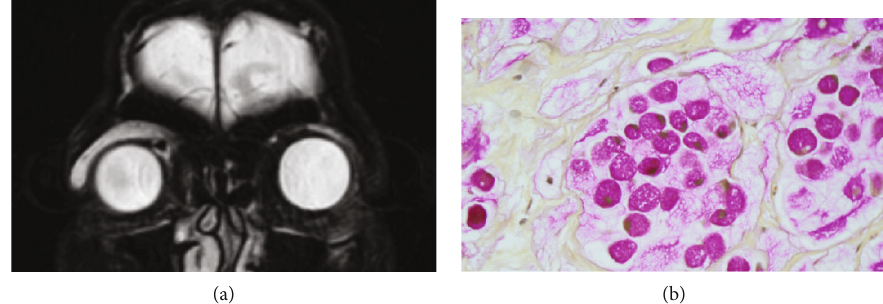
Figure 2: (a) Coronal T2-weighted fat-saturated MR images show a hyperintense mass along the right superior orbit that involves the levator complex and lacrimal gland. (b) Photomicrograph (original magni fi cation, × 60) of the patient ’ s orbital biopsy specimen showing signet ring cells strongly positive for mucicarmine stain